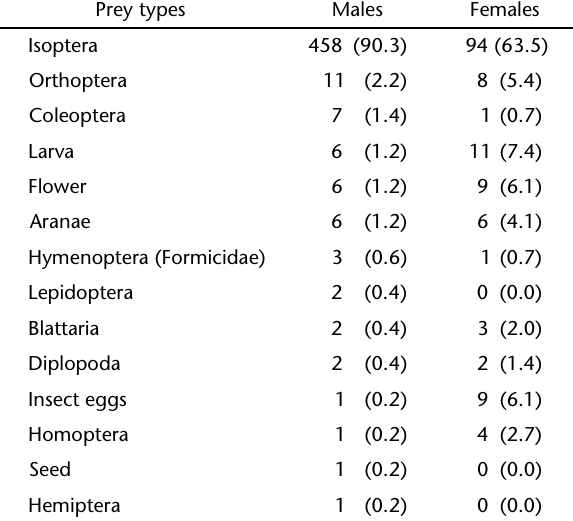
Table III. Diet composition by number (% in parenthesis) of prey consumed by males (N = 16) and females (N = 12) of C. ocellifer at the Morro do Chapéu.